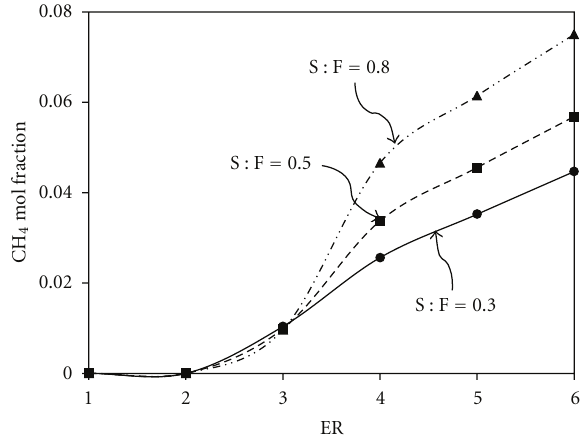
Figure 6: E ff ect of ER on CH 4 production for various S :F, estimated with chemical equilibrium.